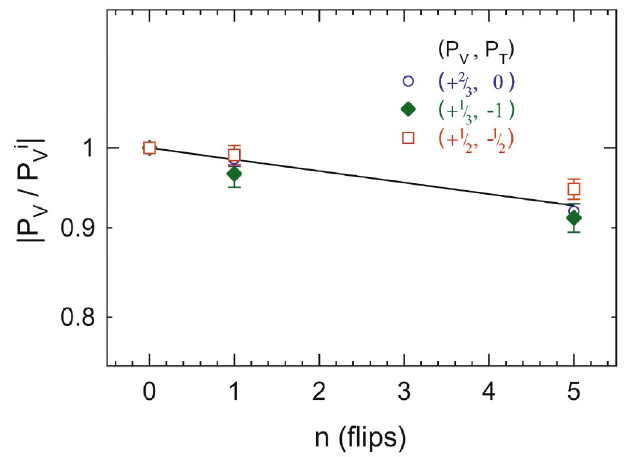
FIG. 9. (Color) The measured vector deuteron polarization ra- tios at 1850 MeV =c are plotted against the number of frequency sweeps. The rf dipole’s frequency ramp time (cid:18) t was 60 s; its frequency half-range (cid:18) f= 2 was 75 Hz , and its R B 0 : 60 T mm . The line is a fit using Eq. (16).